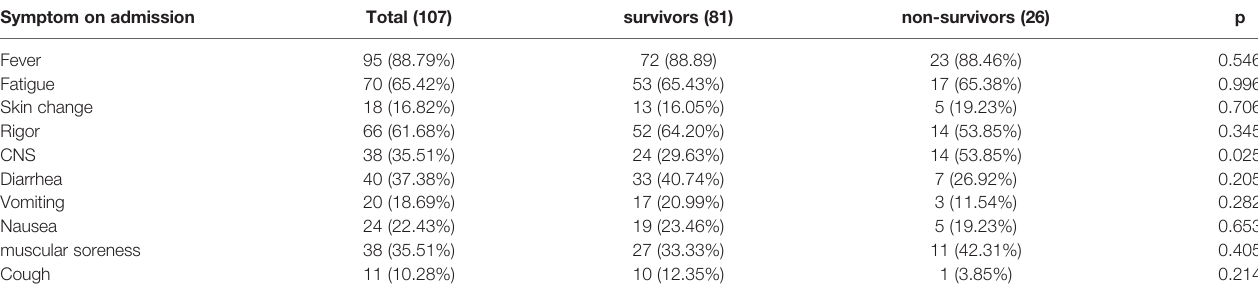
TABLE 3 | Symptomatic characteristics of patients with SFTSV infection at admission.